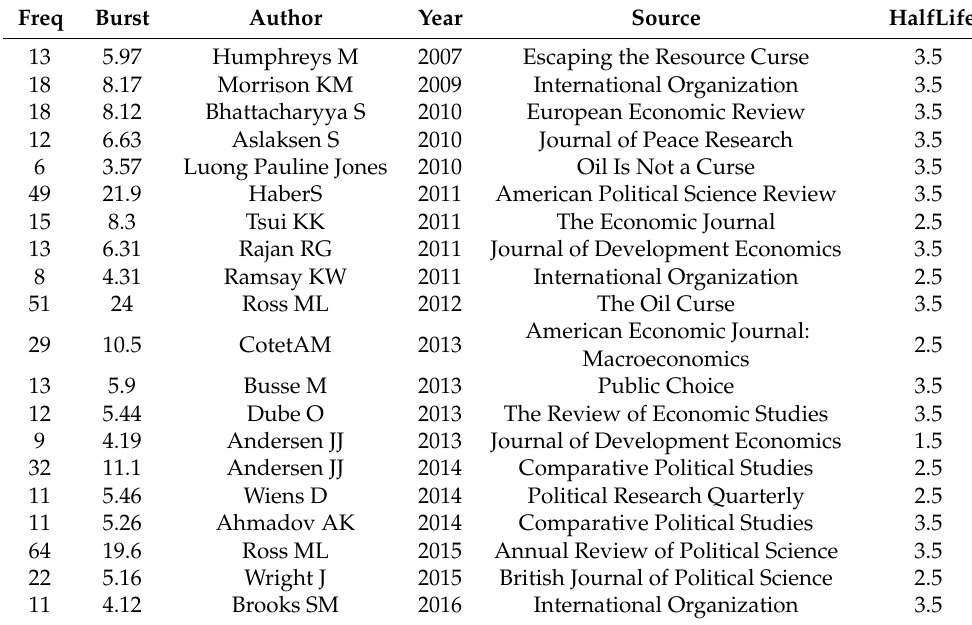
Figure 25. A timeline visualization of the Cluster 2 co-citation network (using Citespace 5.7.R4). Table 8. Exploration and summary of Cluster 2. Table 8. Exploration and summary of Cluster 2. Table 8. Exploration and summary of Cluster